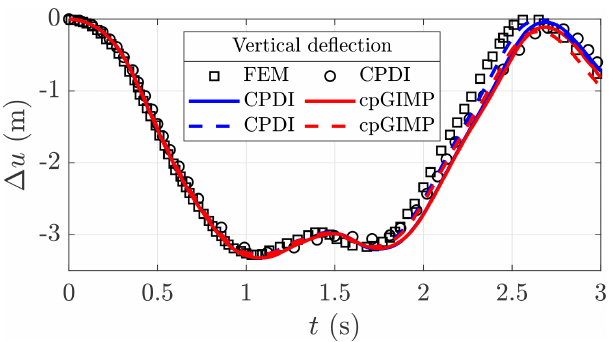
Figure 12. Vertical deflection (cid:49)u for the cantilever beam problem. The black markers denote the solutions of Sadeghirad et al. (2011) (circles for CPDI and squares for FEM). The line colour indicates the MPM variant (blue for CPDI and red for cpGIMP), solid lines refer to a linear elastic solid and dashed lines refer to a neo-Hookean solid. (cid:49)u corresponds to the vertical displacement of the bottom material point at the free end of the beam (the red cross in Fig. 11).